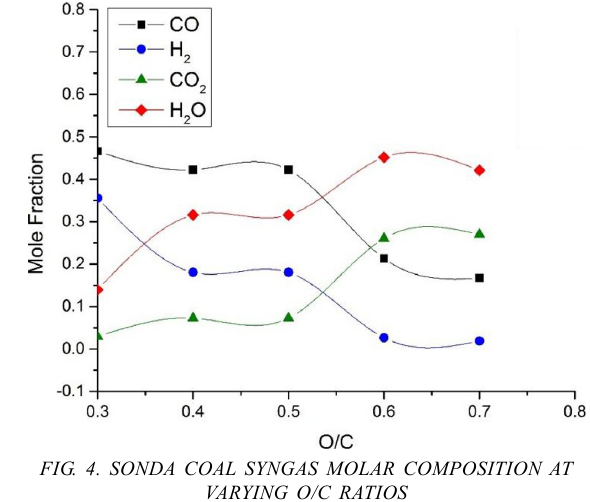
FIG. 4. SONDA COAL SYNGAS MOLAR COMPOSITION AT VARYING O/C RATIOS